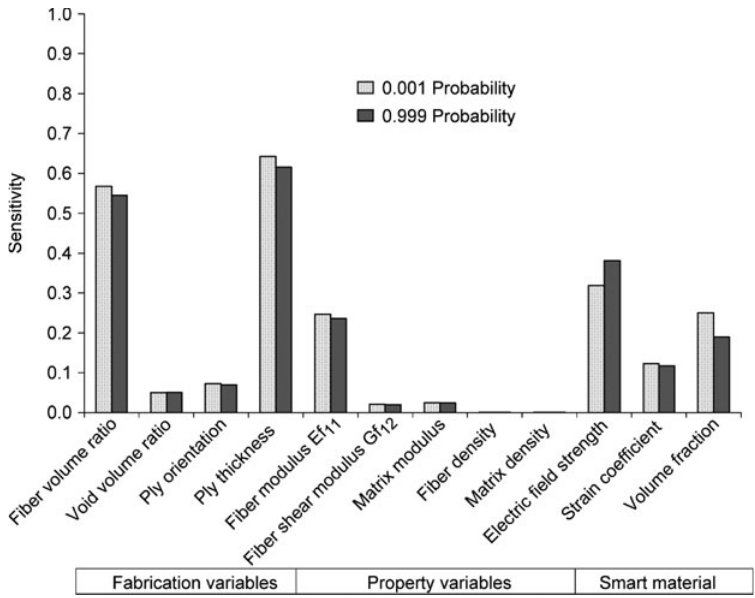
Figure 8 Probabilistic sensitivities of dynamic buckling load of a smart composite shell.